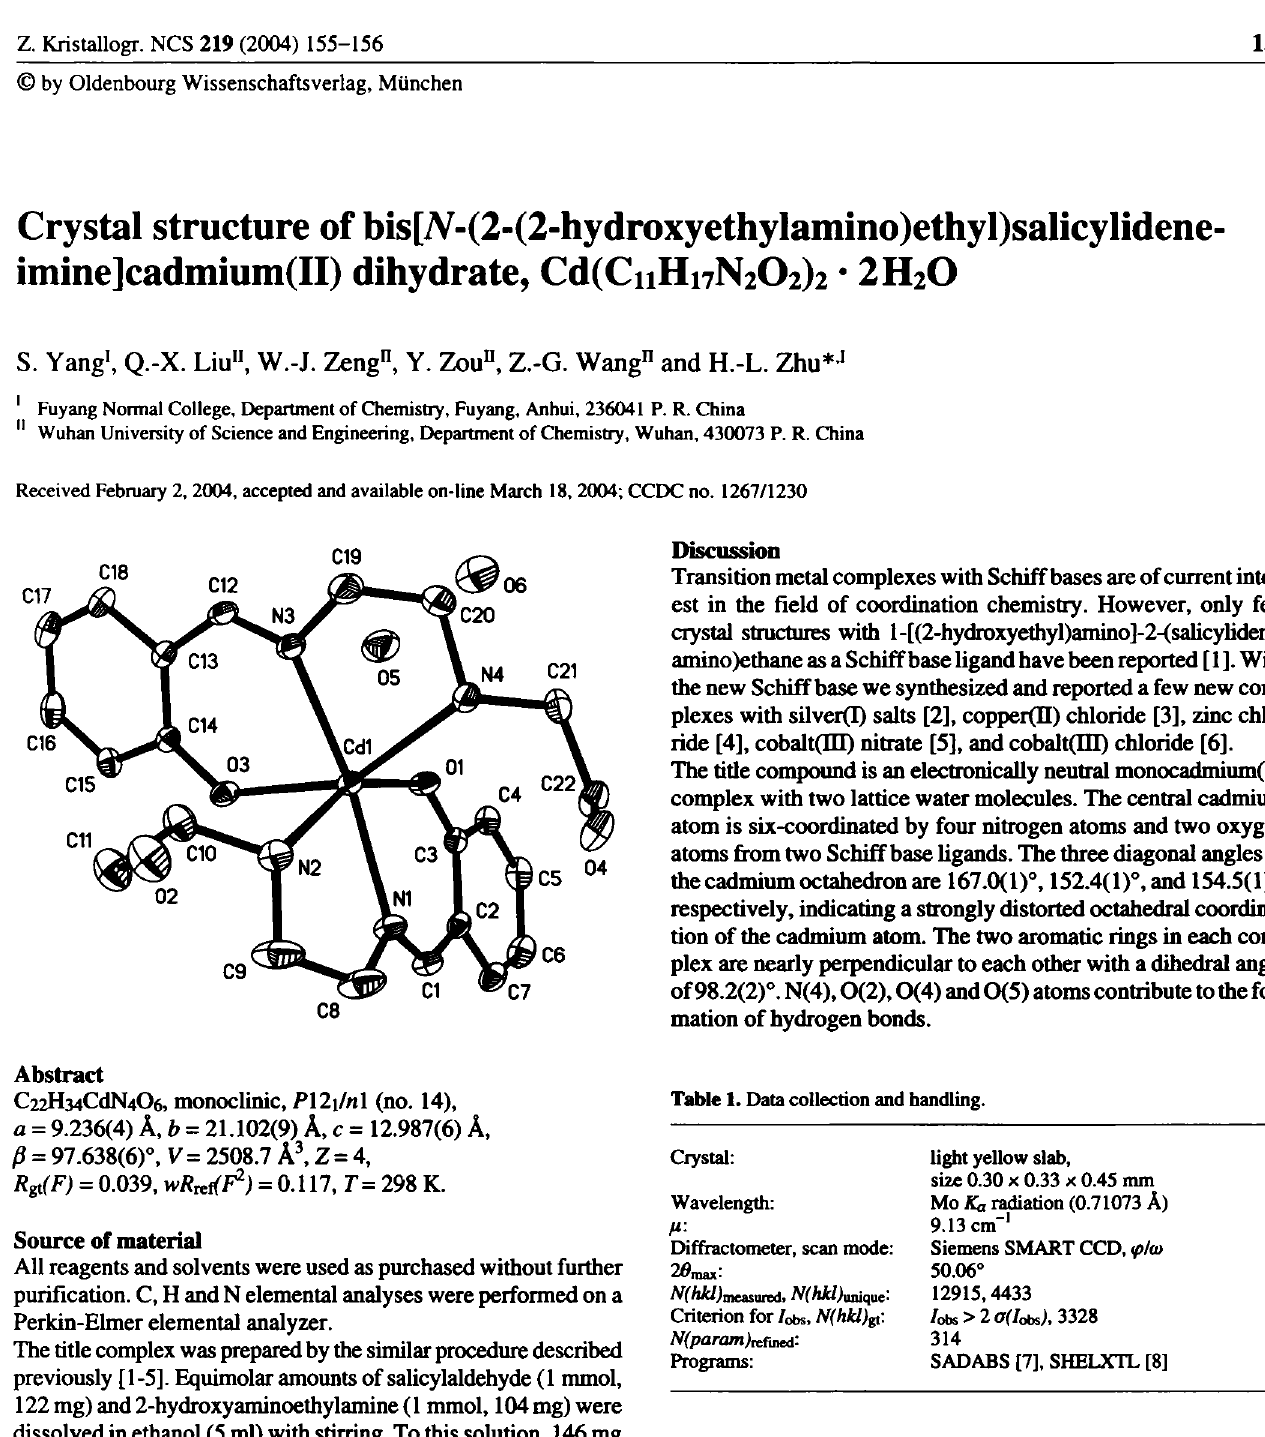
Table 2. Atomic coordinates and displacement parameters (in A 2